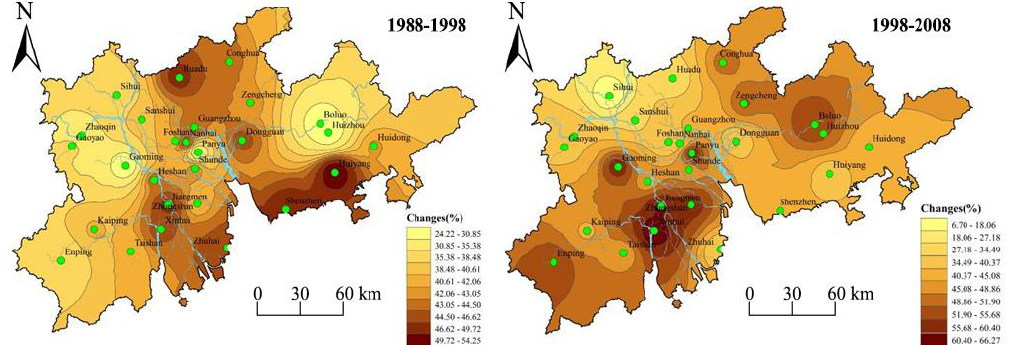
Figure 5: The change of land-based transport network efficiency (NE) in the PRD, 1988-1998 and 1998-2008